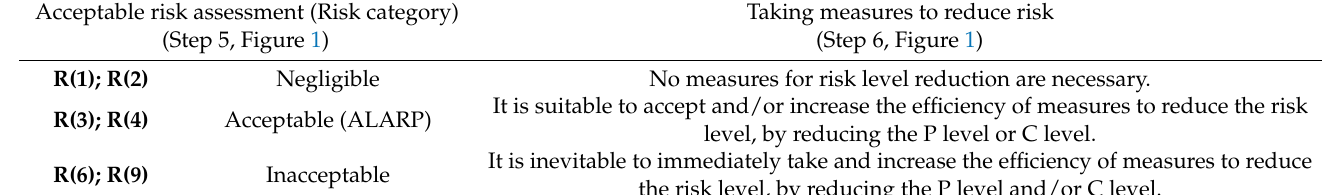
Estimation of Probability ( P ) and Consequence ( C ) , and